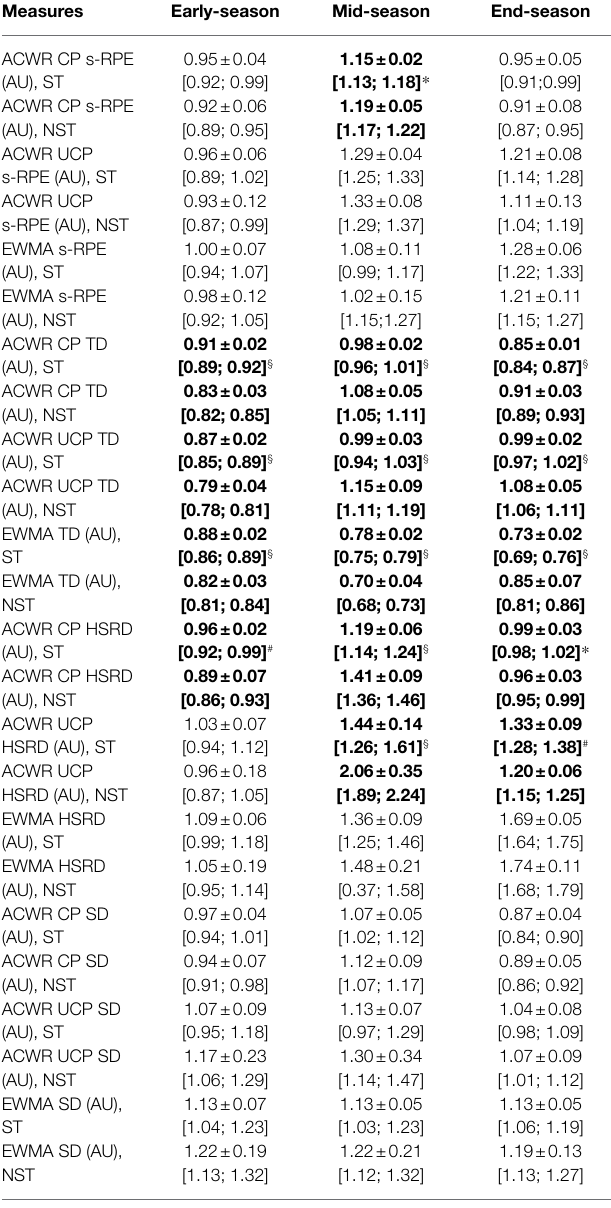
TABLE 2 | Differences between starters and non-starters during the periods of the in-season, mean ± SD [95% CI].